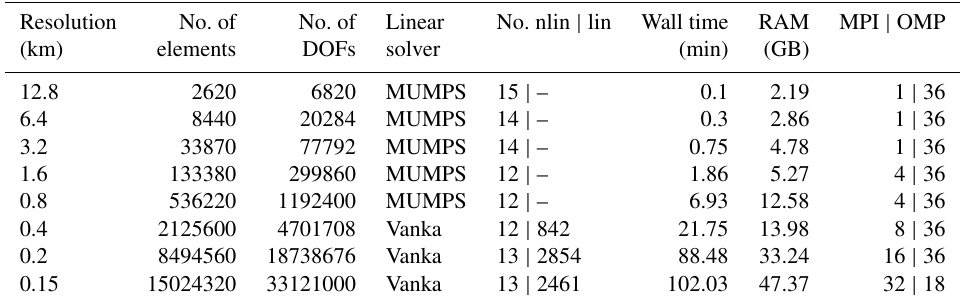
a Simulations are run on the AWI cluster Cray CS400. Each production node is equipped with 64GB RAM and 2 × 18 core CPUs (Intel Xeon Broadwell CPU E5-2697). b Simulations are run at the North German Supercomputing Alliance (HLRN) cluster Lise. Each production node has 362GB RAM and 2 × 48 core CPUs (Intel Cascade Lake Platinum 9242 (CLX-AP)). c Domain decomposition solver with an overlapping multiplicative Schwarz method. Number of sub-domains are set equal to the number of MPI tasks. Table 2. Overview of mesh characteristics and consumed computational resources of the outlet region similar to Table 1. Number of non- linear (nlin) iterations (damped Newton’s method), number of linear (lin) iterations, computational time and physical RAM usage are listed for E = 1, m = 3, FS and P1P1GLS